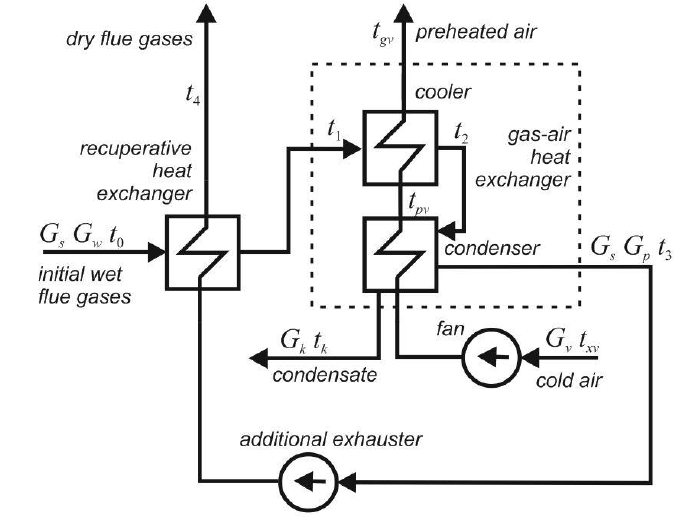
Figure 1. Deep heat recovery of flue gas, installation